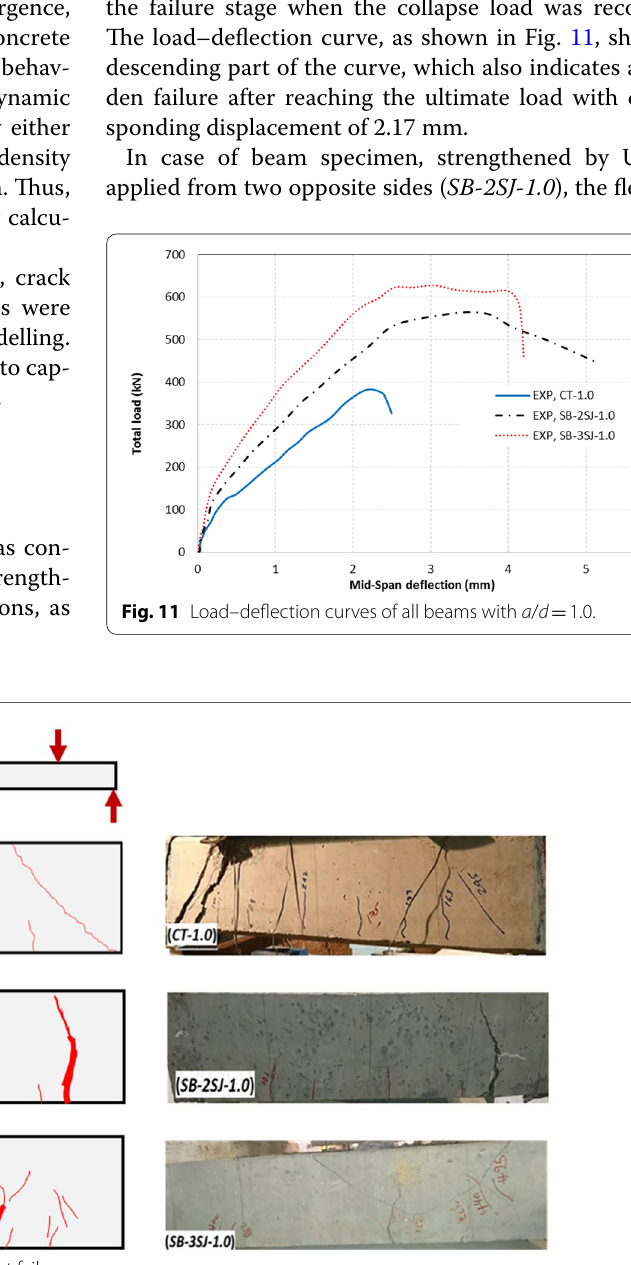
1.0 (a 200 mm) at failure = =